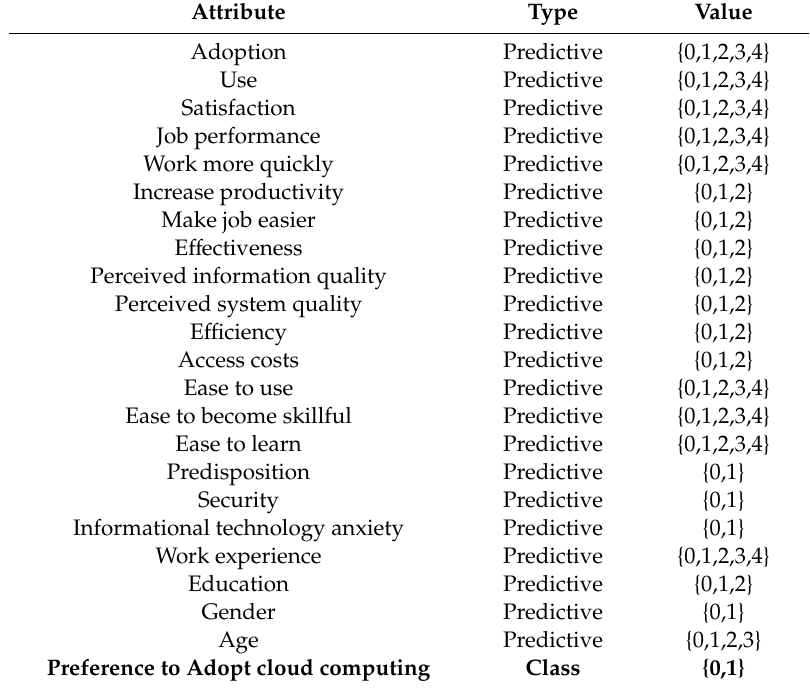
Table 1. Dataset